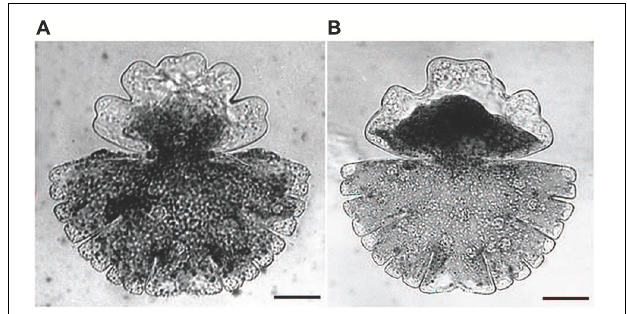
FIGURE 6 | Cell shape malformations of growing Micrasterias cells treated with the cholinergic antagonist D -tubacurarine (A) and with the agonist nicotine (B) during growth (scale bars are 30 µ m). Reprinted with permission from Schiechl et al. (2008), Copyright © 2008 Elsevier Ireland